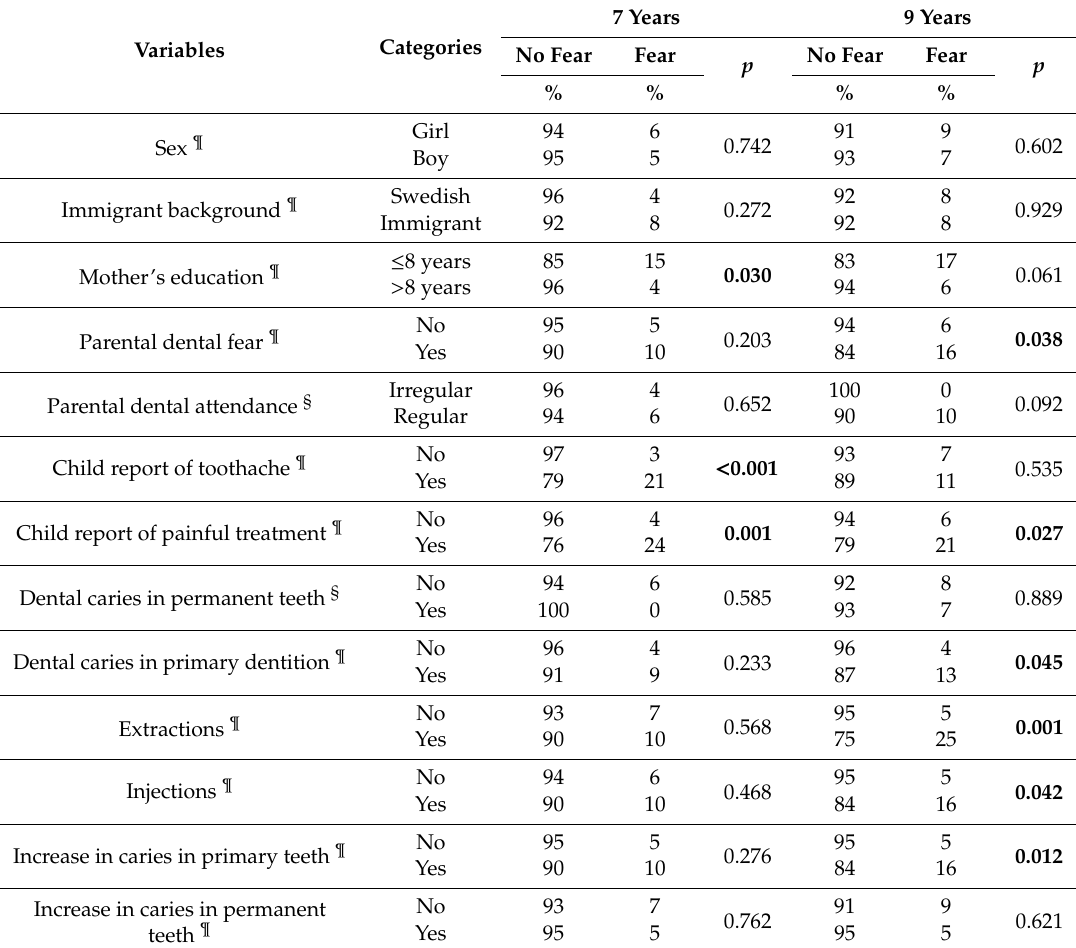
Table 2. Potential risk factors for dental fear at ages seven and nine